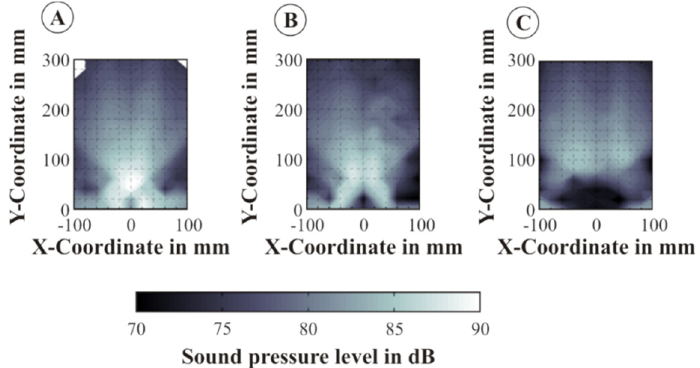
Figure 15. Measured maximum sound pressure level of the radiated ultrasound burst at different heights. ( A ) 10 mm above the plate; ( B ) 30 mm above the plate; ( C ) 70 mm above the plate.